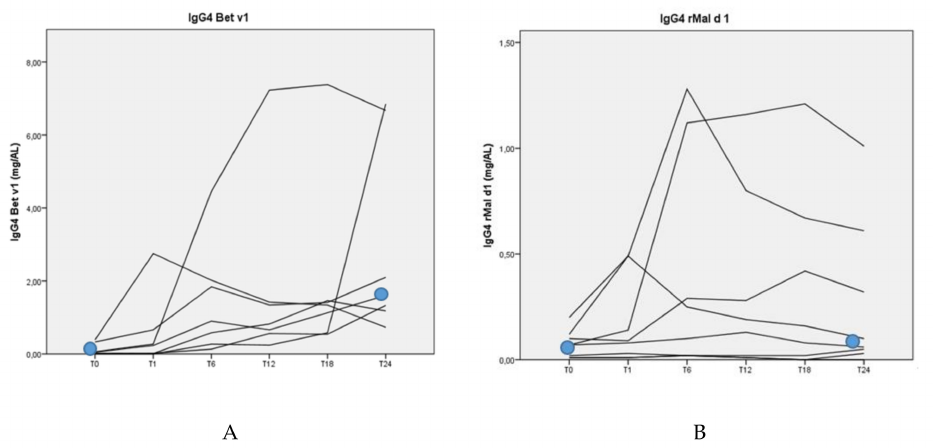
Figure 3. IgG4 in response to Bet v 1 ( A ) and rMal d 1 ( B ) over time (in months) during BP-AIT.